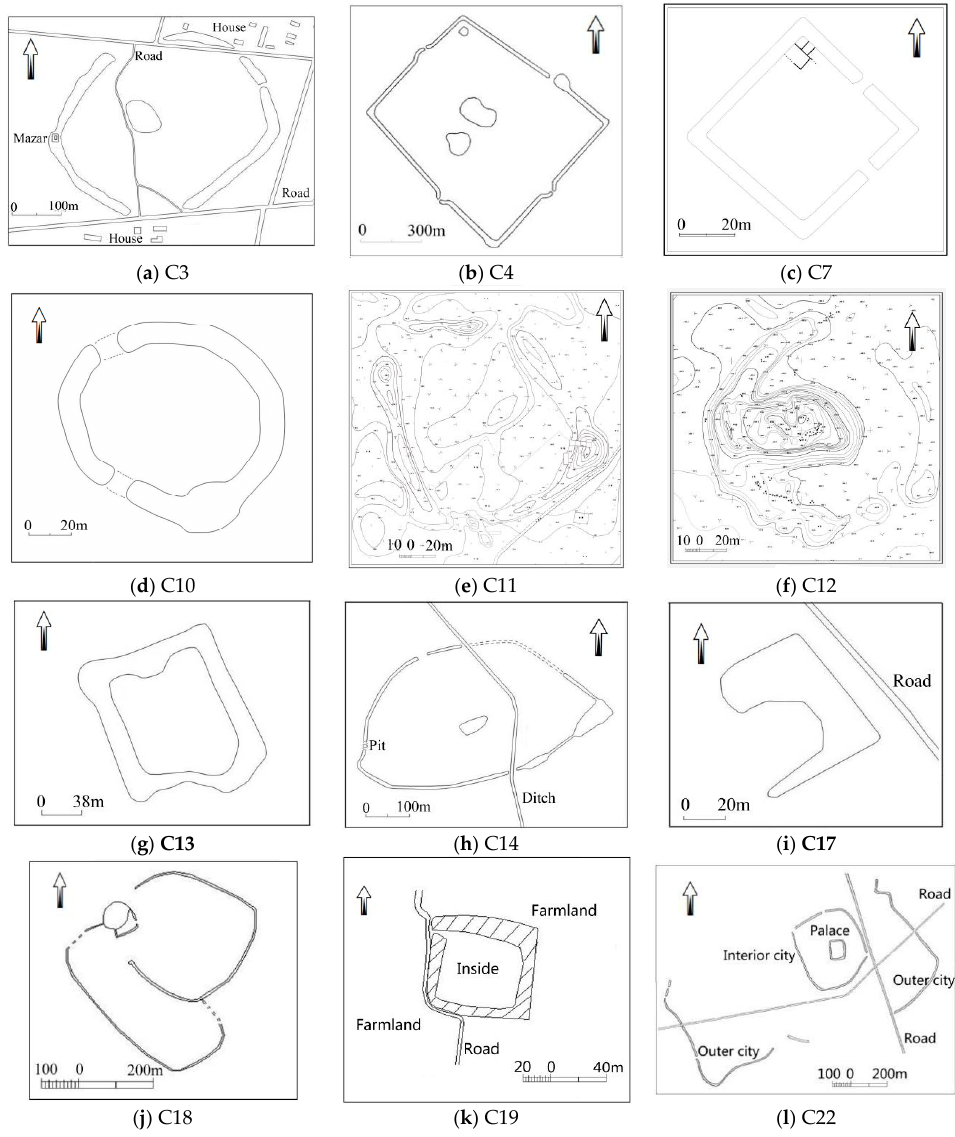
Figure 11. Archaeological planar graphs of some city sites with remains on the surface. The materials are from the third cultural relic census data.